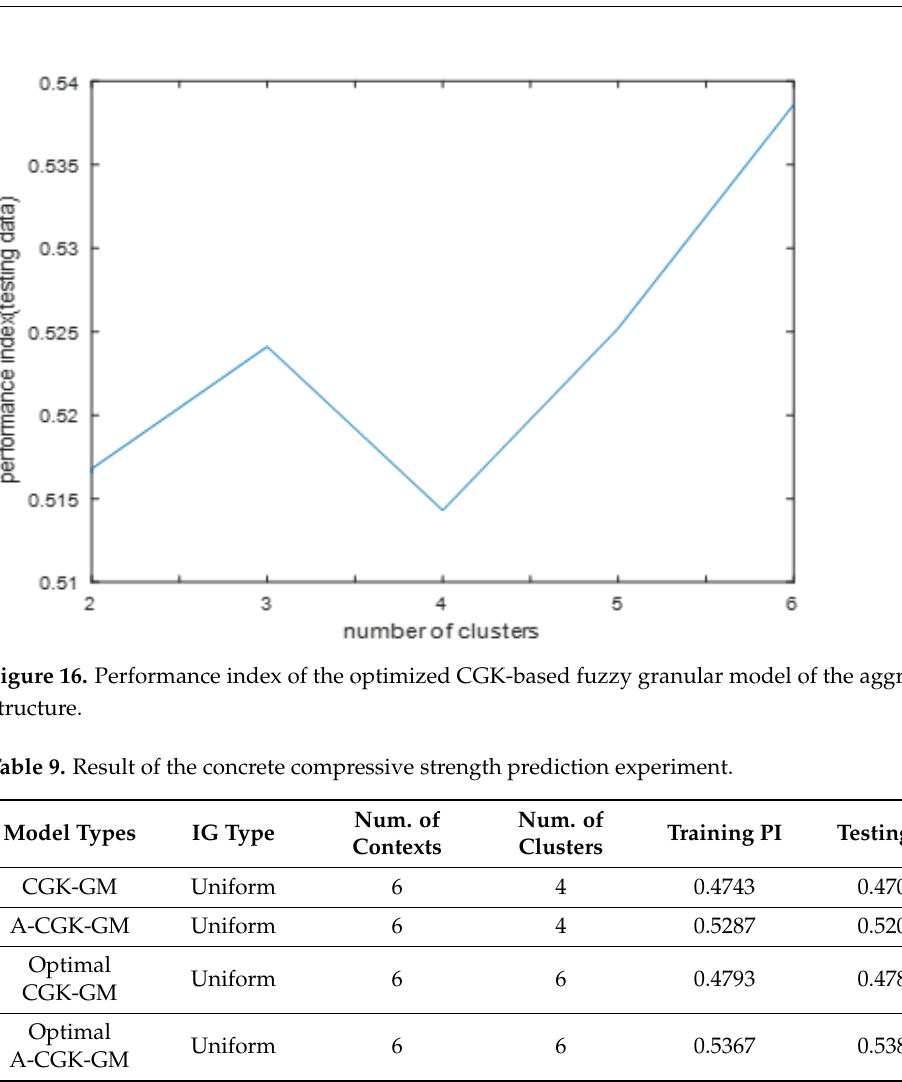
Figure 15. Comparison of the output of the optimized CGK-based fuzzy granular model of the ag- gregated structure and the real output.